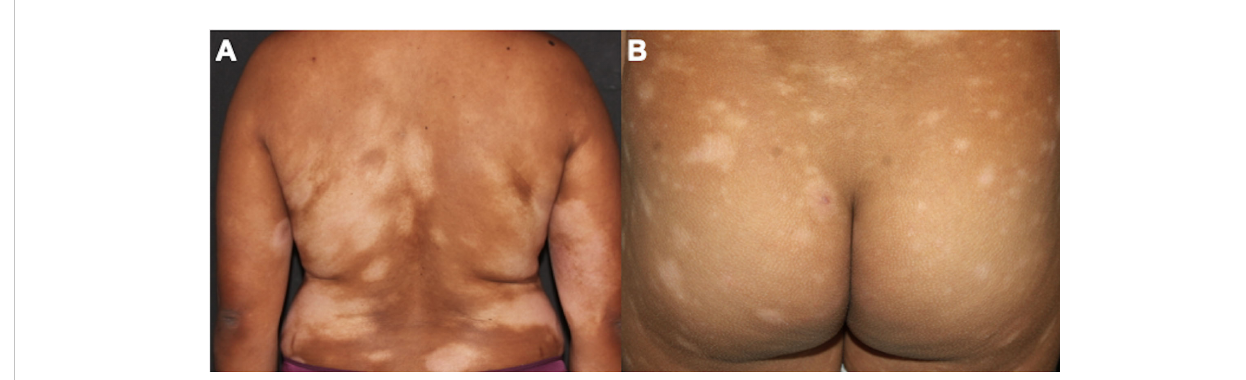
FIGURE 5 Hypopigmented MF. Multiple hypochromic patches on the trunk and arms (A) , and on the buttocks (B) .